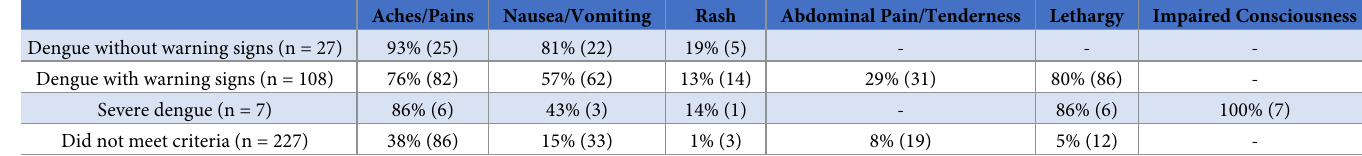
Table 1. Symptoms of participants (n = 369) characterizing dengue disease. Abdominal pain/tenderness and lethargy are both warning signs. Aches/Pains Nausea/Vomiting Rash Abdominal Pain/Tenderness Lethargy Impaired Consciousness Dengue without warning signs (n = 27) 93% (25) - Dengue with warning signs (n =